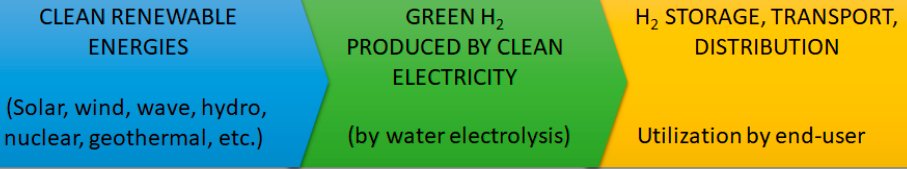
Figure 2. Integrated RE H 2 system and economy.